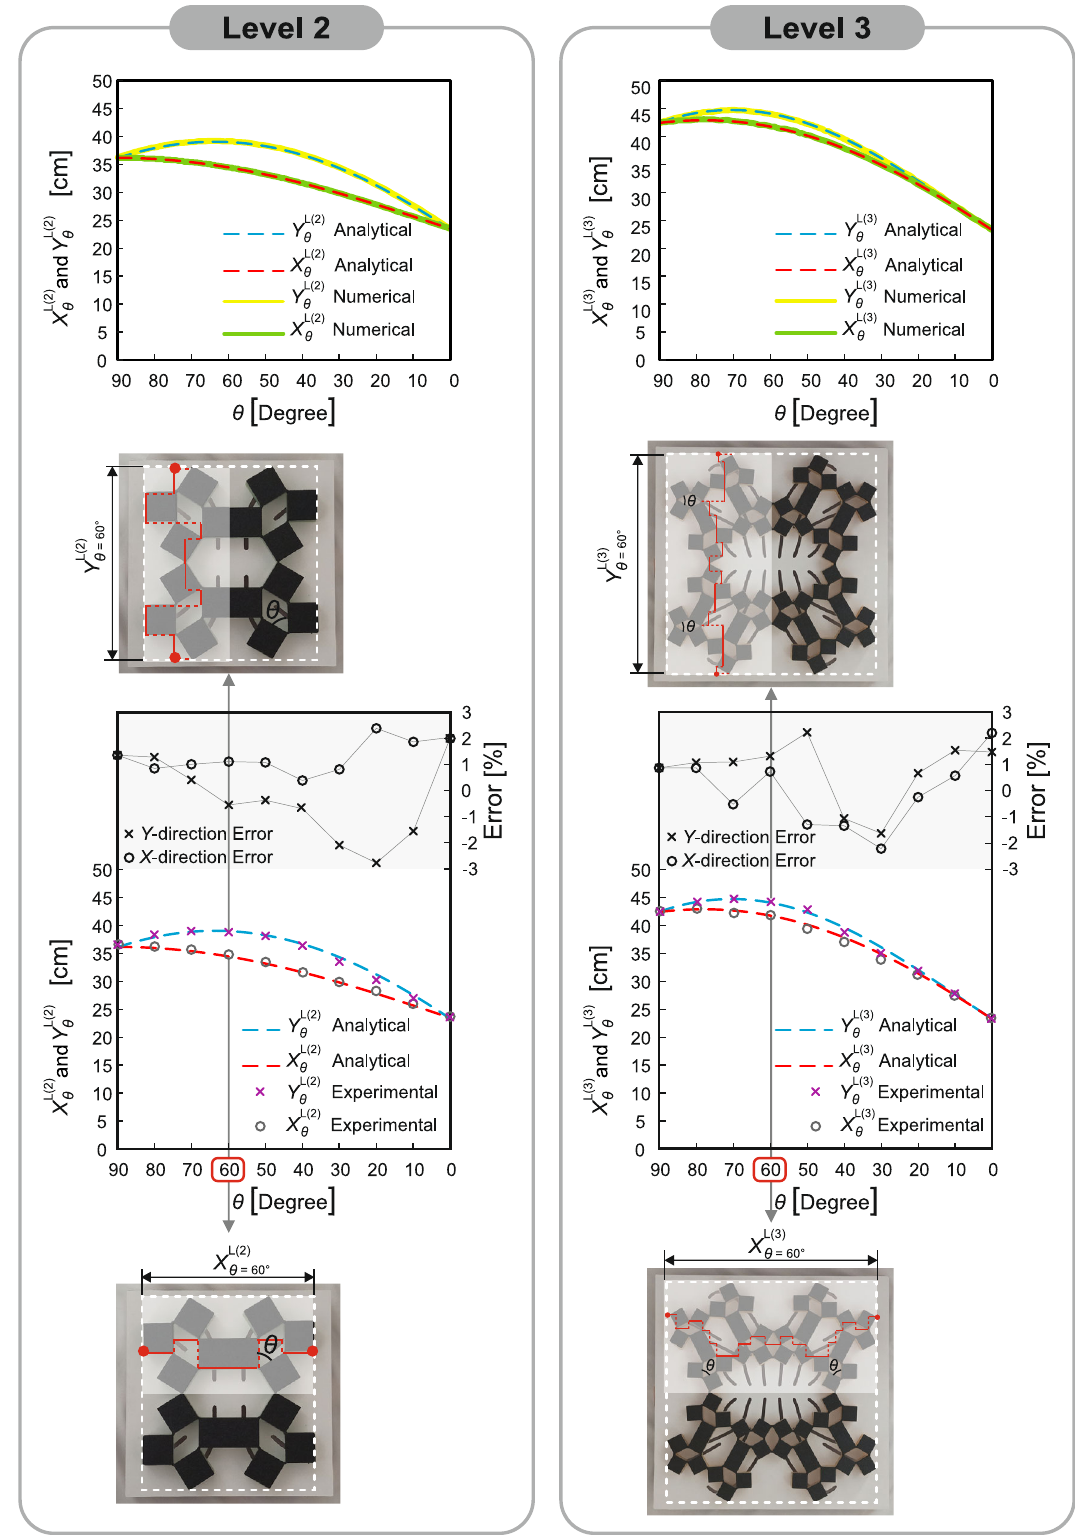
Fig. 3 Geometric variations during deformations for ENAs of levels 2 and 3 in terms of deployment angle θ . The analytical results are compared with numerical and experimental results. At 60°, it is shown how X θ and Y θ (i.e., the distance between red circles in the X - and Y -directions, respectively) are divided into smaller, measurable segments on the plan views of the experimental models. The analytical and numerical results are represented continuously, whereas the experimental results are measured at different deployment angles from 90° to zero in increments of 10°.